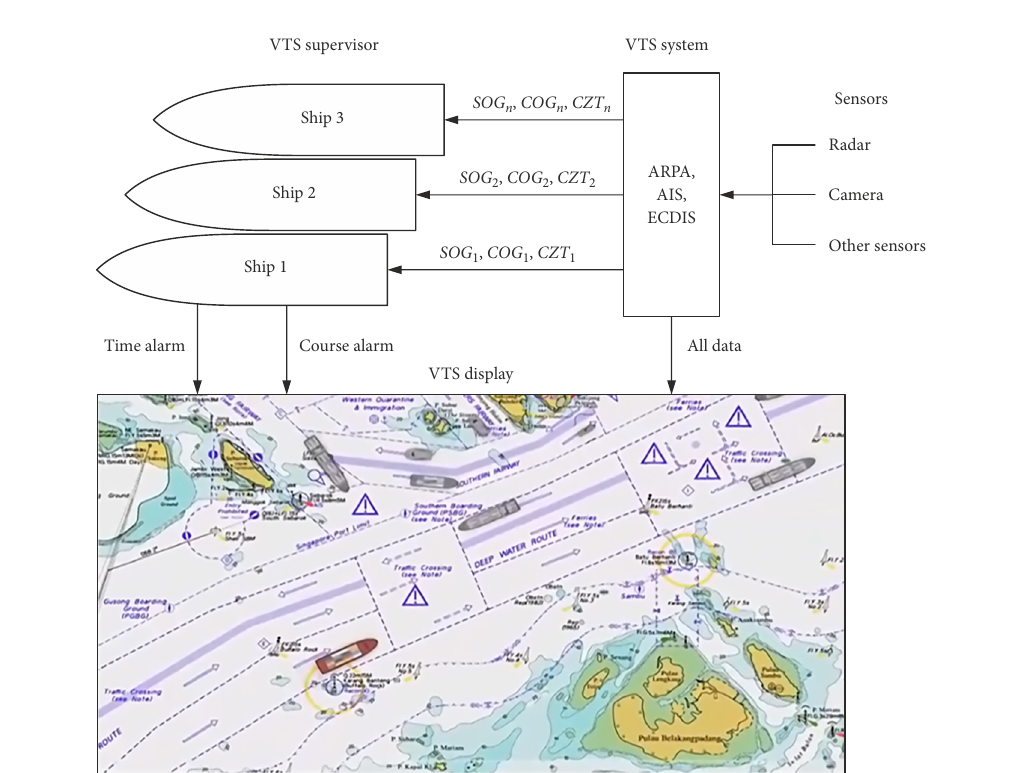
Figure 4. Integration of the VTS supervisor, VTS system and VTS display (SAFETY4SEA